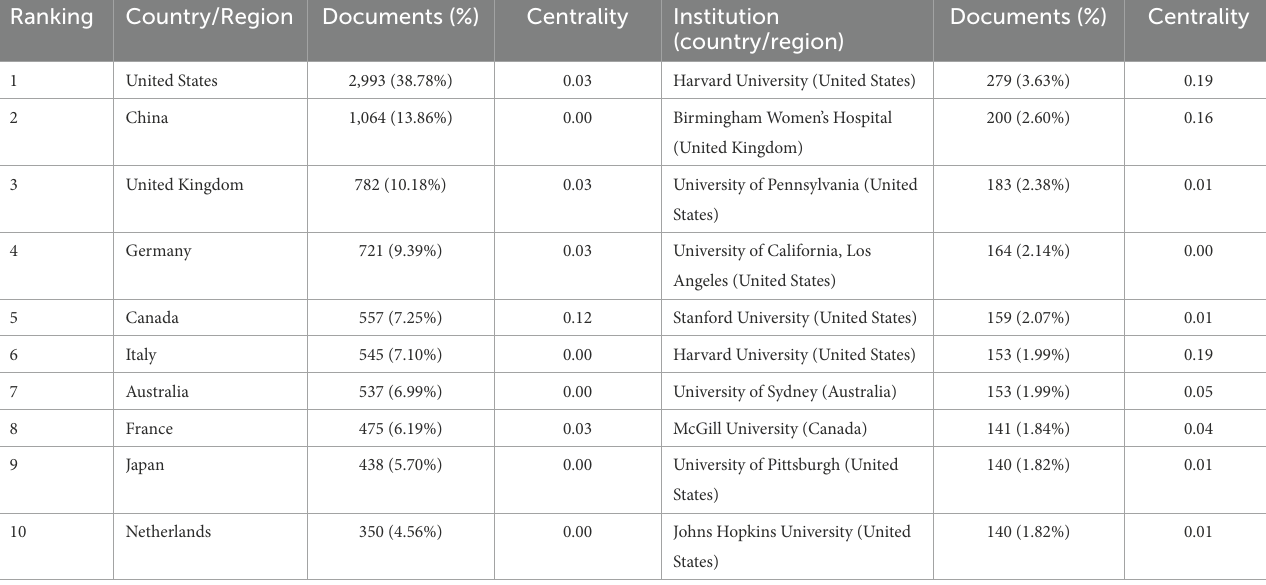
TABLE 1 Top 10 countries/regions and institutions in terms of number of articles issued.